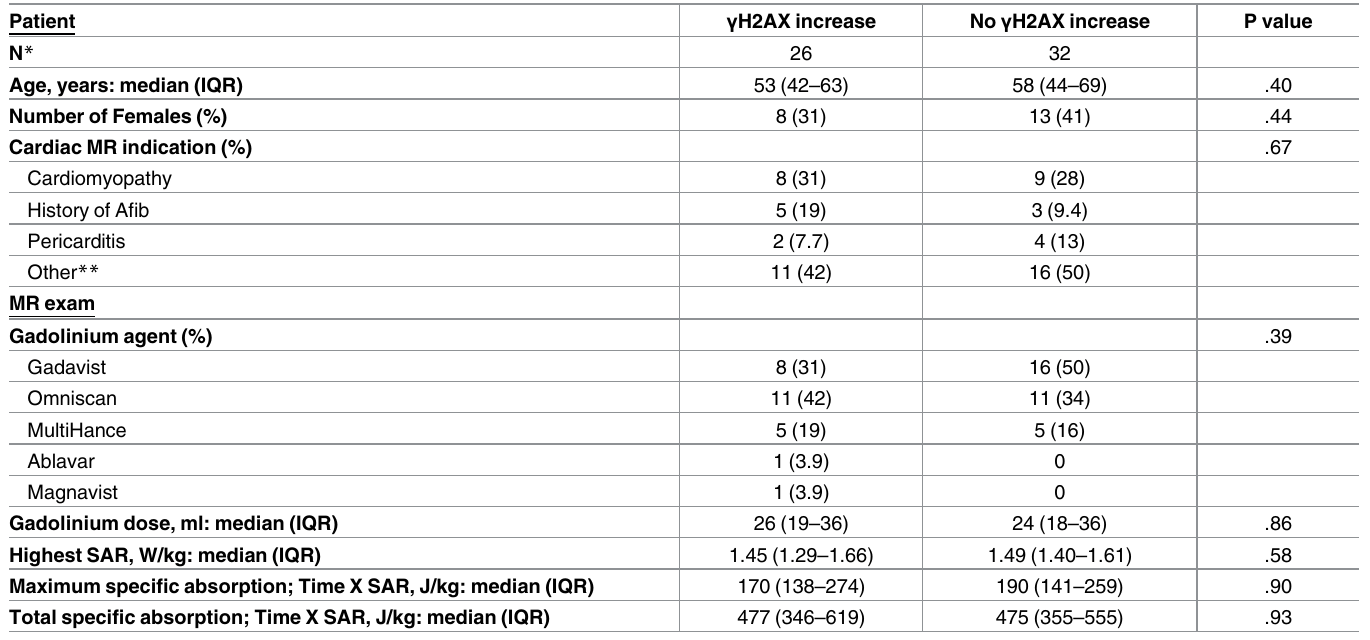
Table 3. Characteristics of patients with > 10% increasein γ H2AX.